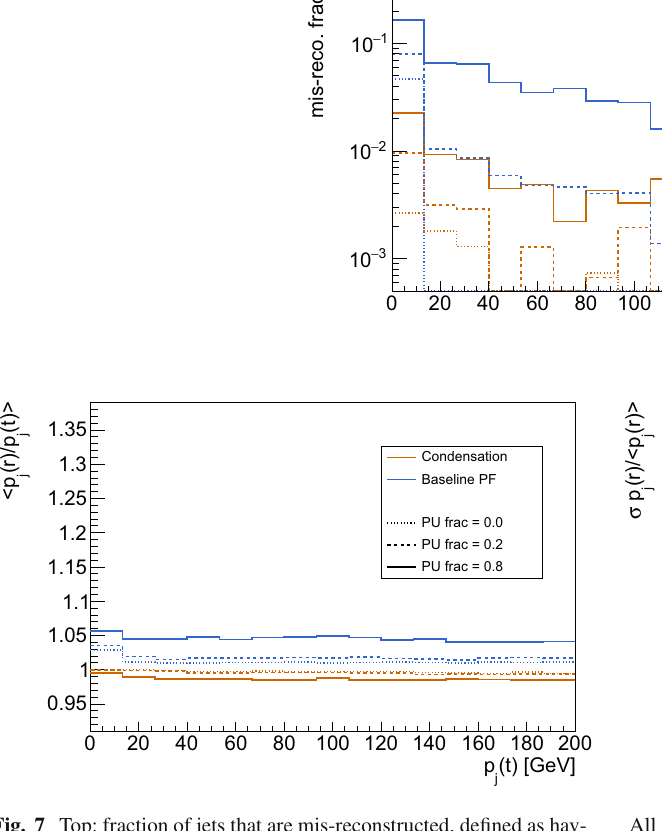
All distributions are shown for different fractions of charged particles associated to pileup (PU frac.). All distributions are shown as a function of the true jet